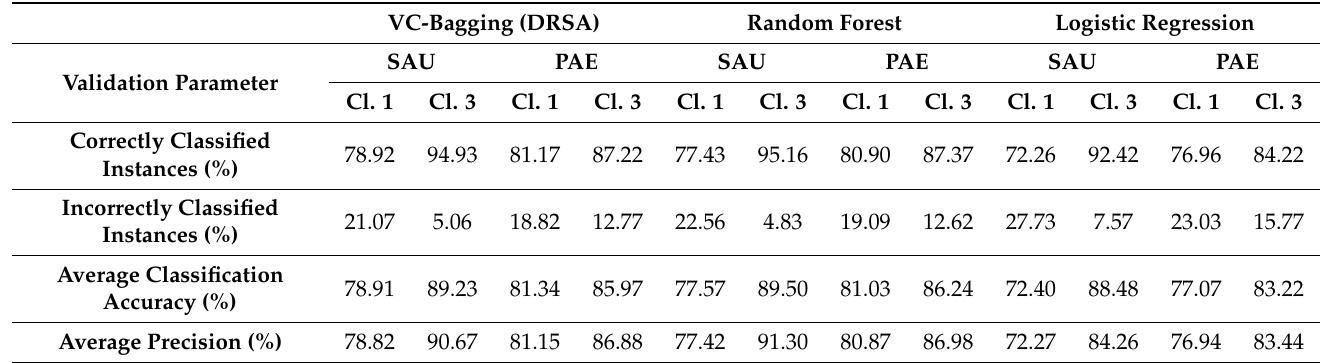
Table 3. Comparison of DRSA with alternative